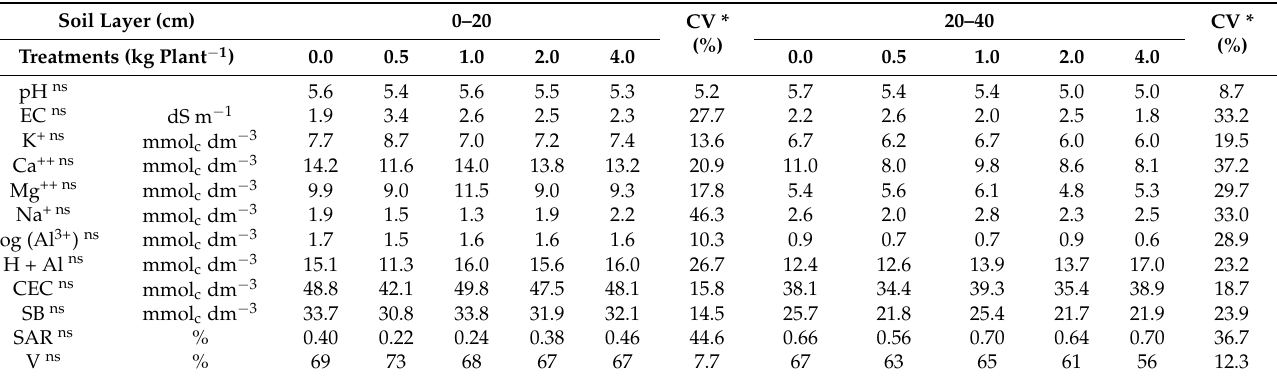
Table 3. Means of soil chemical attributes 2 years after application of sun-dried green coconut husk biochar.